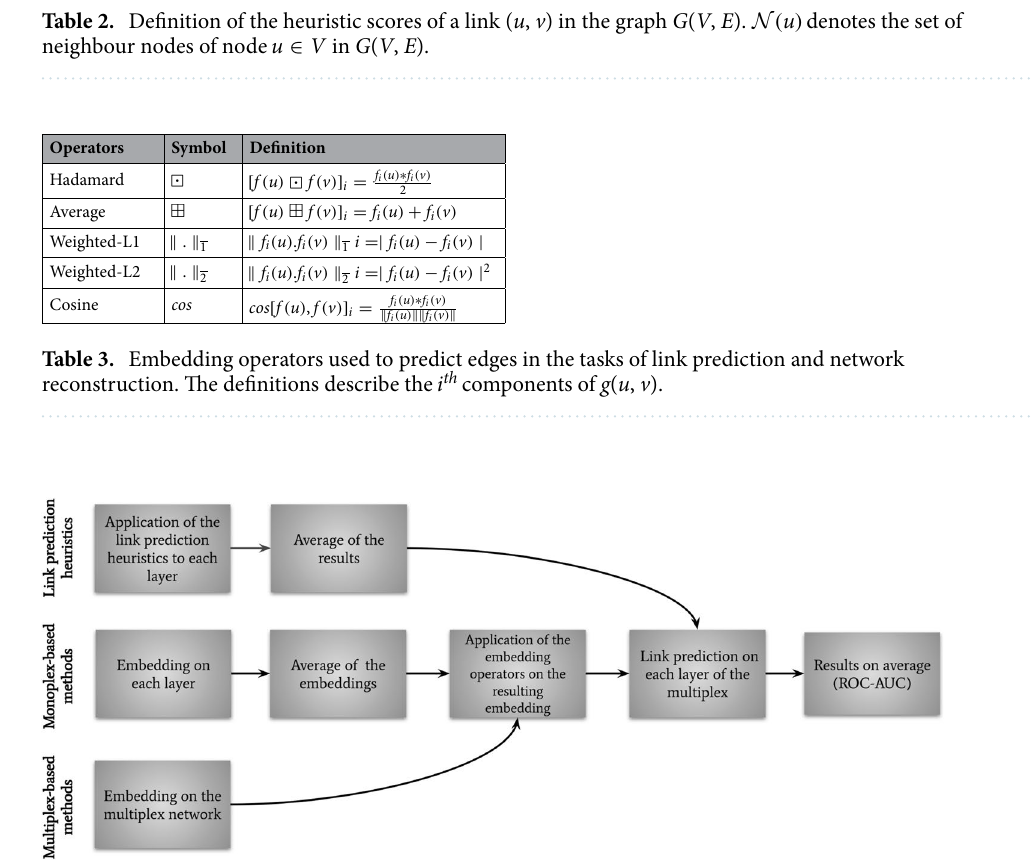
Figure 3. General approach for link prediction on multiplex networks: (top) for the link prediction heuristics, we apply them to each layer and average them across all layers; (center) for monoplex-based methods, we embed each layer with the given method, then average it; (bottom) for multiplex-based methods, we apply the specific embedding method to the network. The embedding operators are then applied to monoplex- and multiplex- based method embeddings. The three types of methods are finally evaluated for link prediction using a binary classifier and a ROC-AUC is